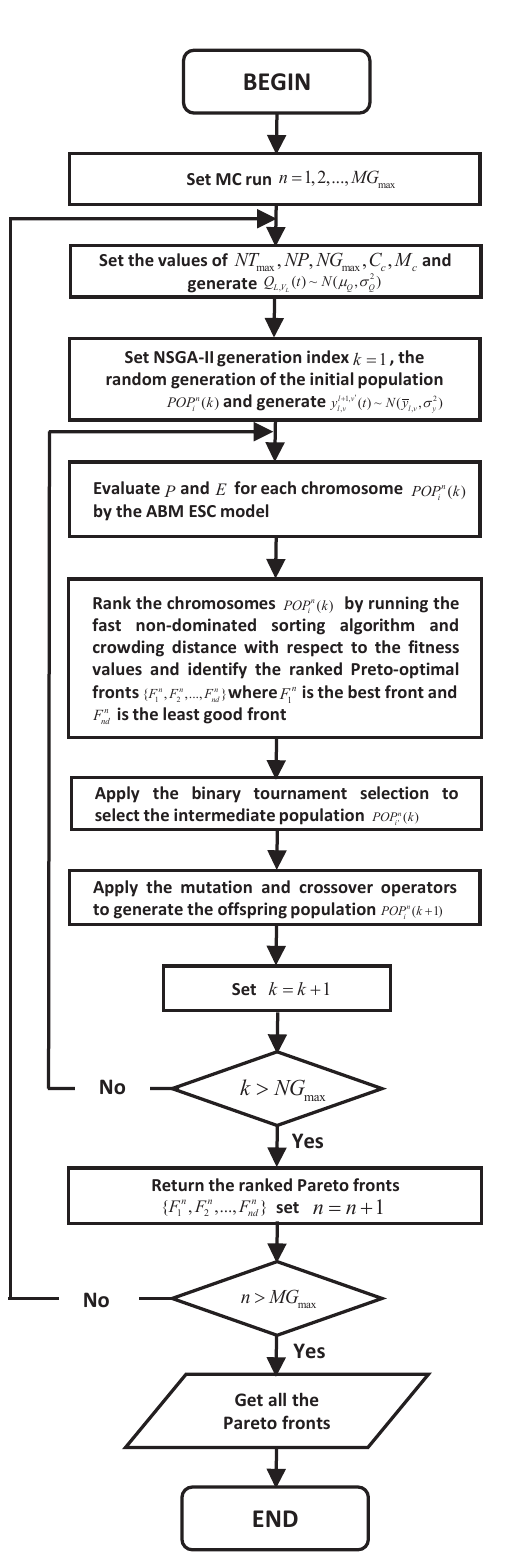
Figure 8. The flowchart of the Agent-based Modeling Multi-Objective Optimization (ABM-MOO)